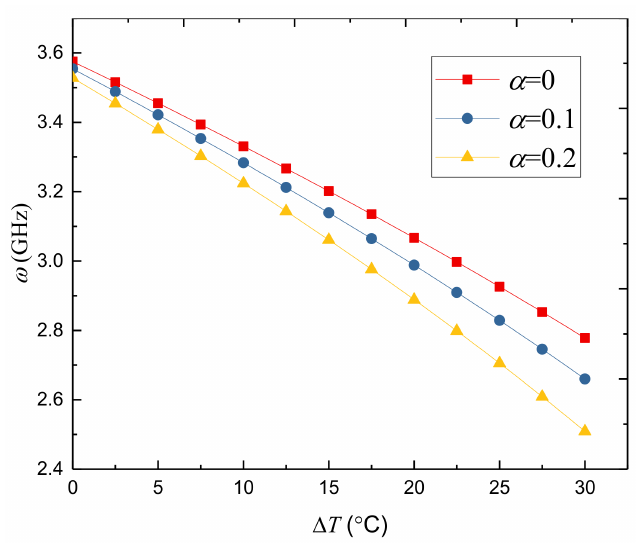
Figure 2. Variation of natural frequency ω (GHz) against temperature change (cid:52) T ( ◦ C) for different porosity volume fractions of the FGPM-I nanoshell ( n = 3, N = 20).